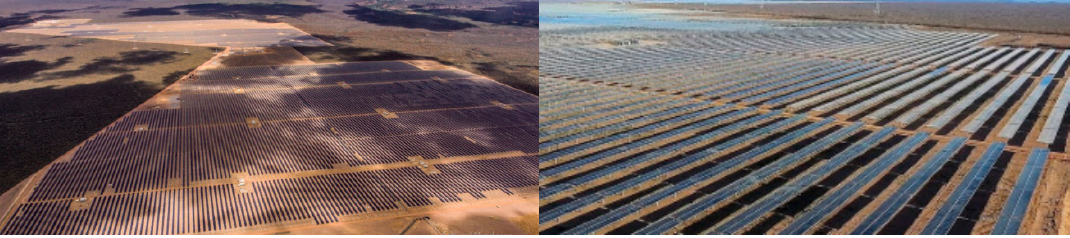
Figure 1. Pictures of the 300 MW PV plant in Brazil.